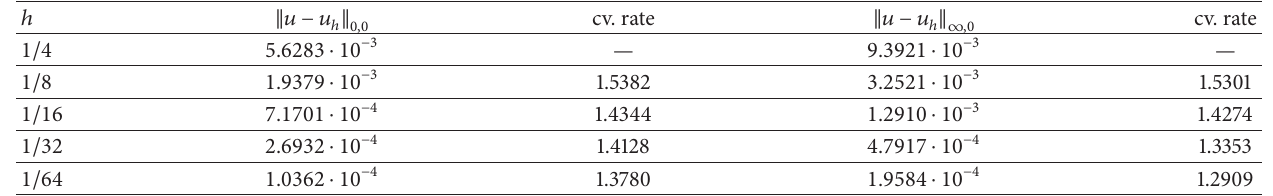
Table 2: The experiential error results and convergence rates of Example 1